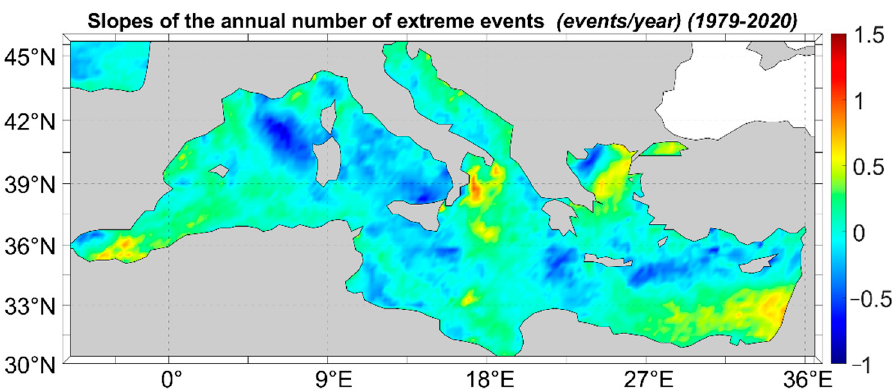
Figure 12. Linear slope of the number of extreme wind